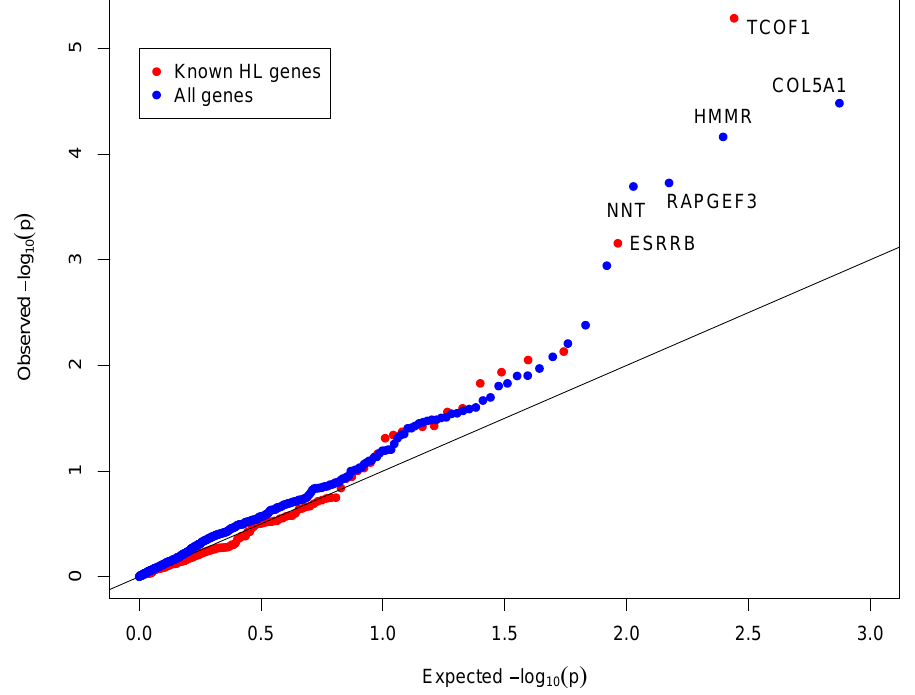
Fig 4. QQ-plot for association of deleterious variant burden with degree HL in 173 known HL genes (red, case carriers > 0) and across 373 genes not previously associated with hearing loss (blue, case carriers > 25). Genes significant at FDR < 0.05 are labeled. Genomic inflation factor λ = 0.78 for known HL genes and 1.44 for genes not previously associated.